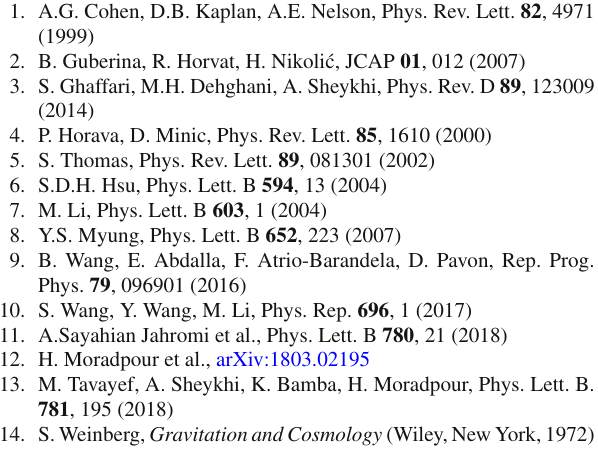
Fig. 9 v 2 s versus (cid:3) D for the sign-changeable interacting THDE with the Hubble cutoff. Here, we used (cid:3) k = 0 (upper panel), (cid:3) k 0 = 0 . 1 (lower panel), δ = 0 . 6, n = 0 . 05 and ω = 1000 as the initial conditions